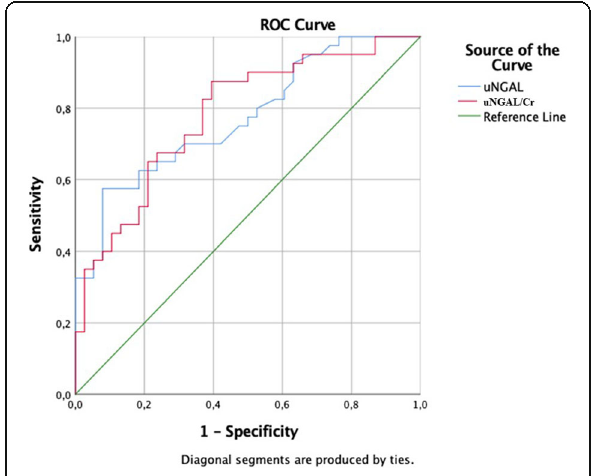
Fig. 1 Receiver operating characteristic curves for uNGAL and uNGAL/uCr in patients with Familial Mediterranean Fever